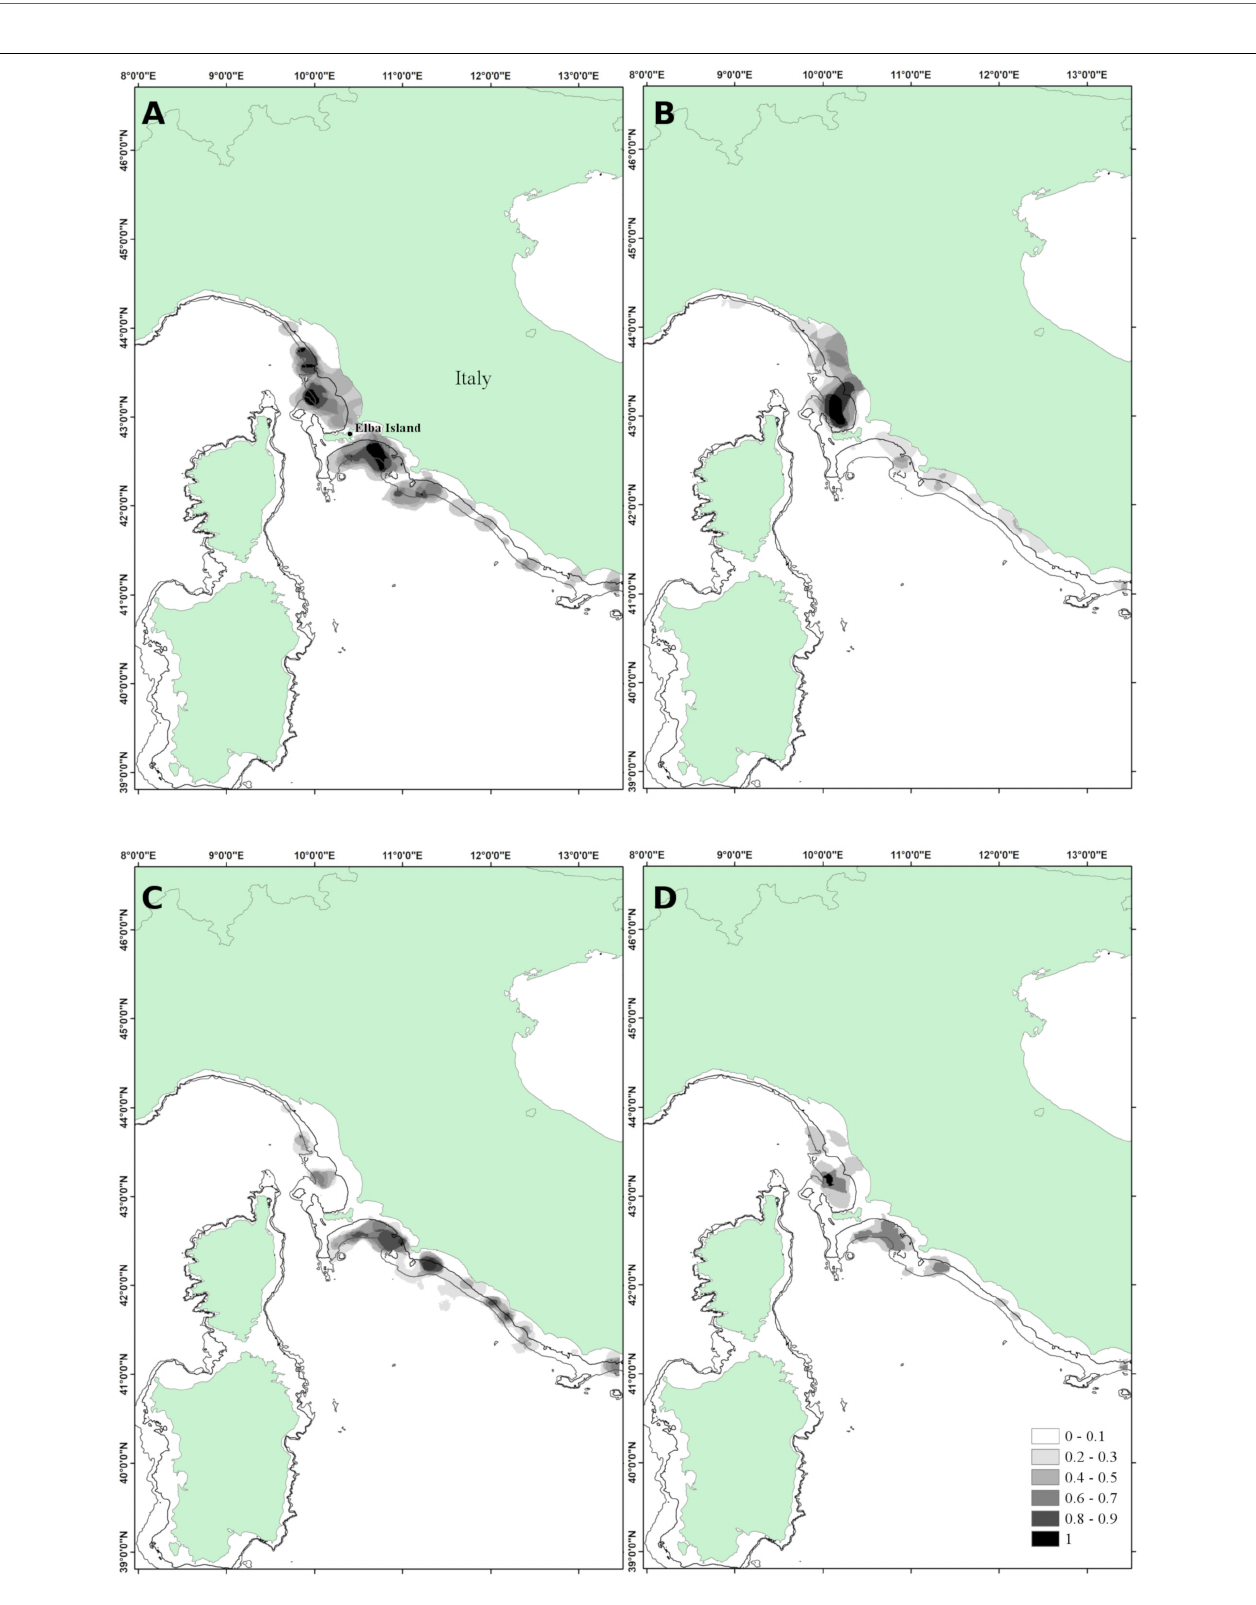
FIGURE 5 | Area 3 – Ligurian and northern Tyrrhenian Seas. (A) Persistence index of Merluccius merluccius ; (B) persistence index of T. trachurus ; (C) persistence index of Parapenaeus longirostris ; (D) interspecific persistence index (IPI). Depth contours shown are 100 and 200 m.